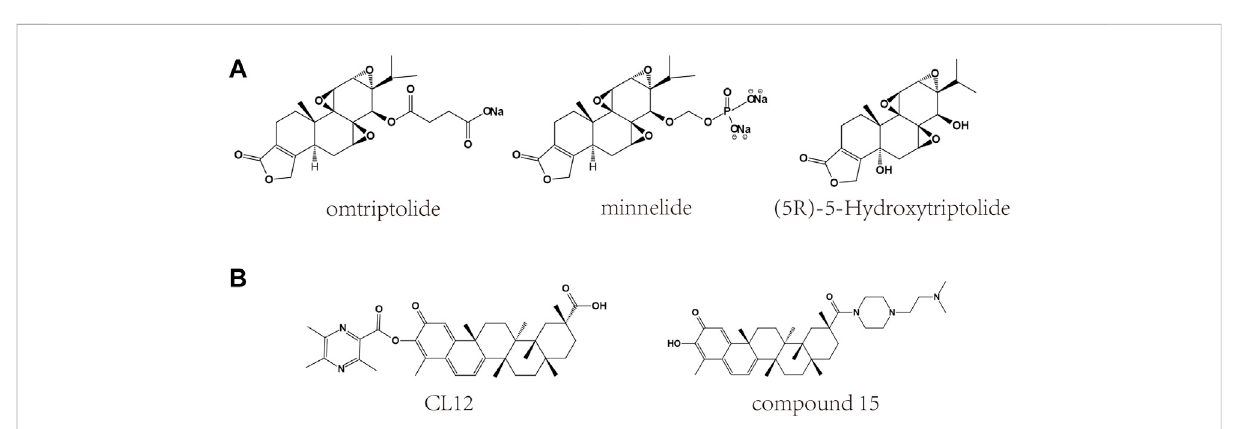
FIGURE 4 Chemical structures of derivatives of triptolide and celastrol. (A) Chemical structures of derivatives of triptolide. (B) Chemical structures of derivatives of celastrol.